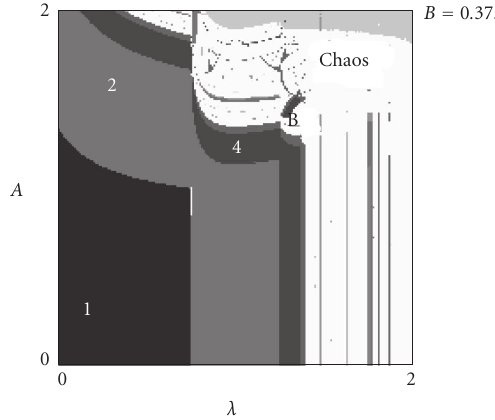
Figure 2.2. Parameter space ( λ , A ) of the slave system for fixed parameter of coupling B = 0 . 375. It is designated the bicritical point B (1.401155, 1.124981), which corresponds to simultaneous transition to chaos in both